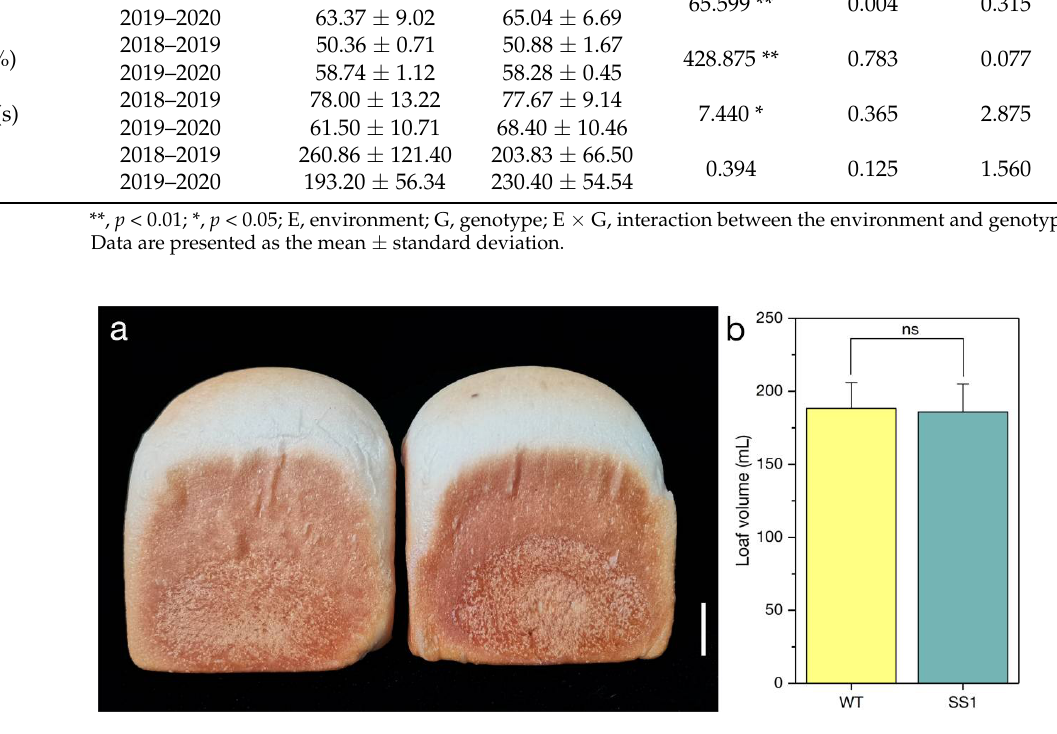
Figure 4. Q s1 has no effect on the bread loaf volume. ( a ) Comparison of the intact ss1 ( left ) and wild-type (WT) ( right ) loaves. Scale bar, 2 cm. ( b ) Comparison of the ss1 and WT loaf volumes. ns, not significant. Because a missense mutation in the sequence encoding the AP 2 domain can decrease the spike density without altering processing quality parameters, the normal-spike mu- tant NS 8 containing the Q c1 -N8 allele was isolated from the M 2 population of the mutant S-Cp 1-1. The NS 8 plants had a normal spike, which was similar to the ‘Shumai482 (cid:48) spike (Figures 5a and S2a). Compared with the Q allele sequence, Q c1 -N8 contains two missense mutations (GenBank No. OK041023), with one in the sequence encoding the second AP 2 do- main and the other in the microRNA172-binding region (Figures 3 and S1). When compared with the WT control (plants with only the Q allele; Figure 1), the mutant NS 8 plants were shorter (Figures 5b, 6b, and S2b,j) but had a similar spike length (Figures 5a, 6d, and S2a,l) and spike density (Figures 6f and